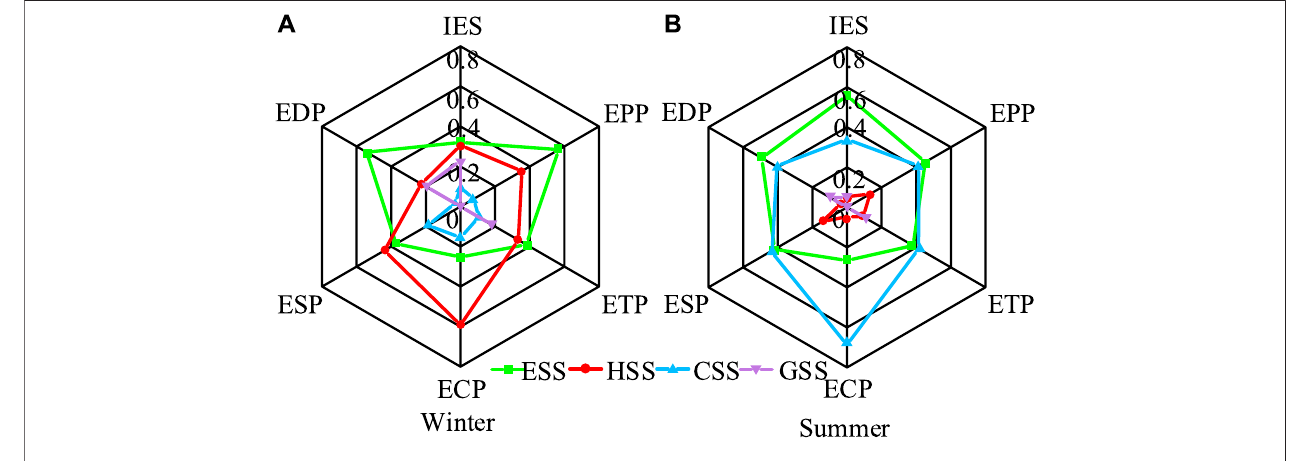
FIGURE 4 | The weight of each subsystem in winter and summer.